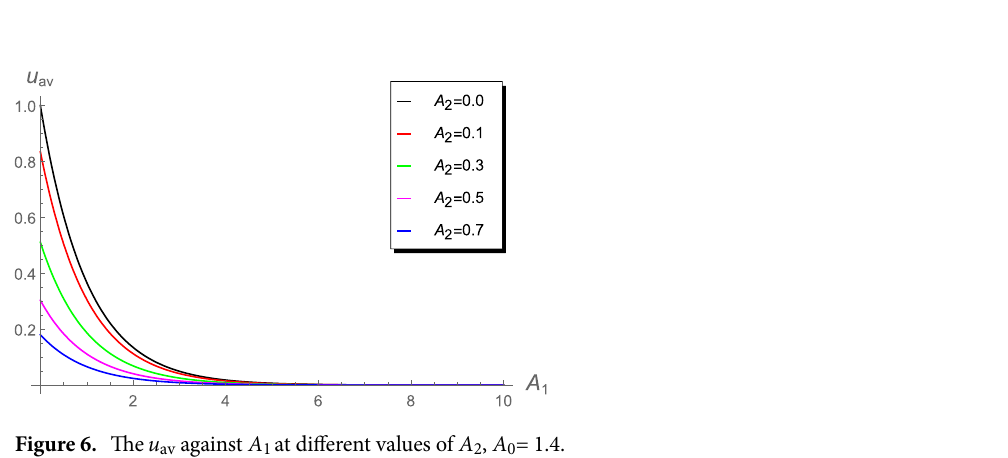
Table 3. Comparisons of present roots (cid:31) 1 , (cid:31) 2 , and (cid:31) 3 of Eq. (36) and the corresponding results in Ref. 4 using A Eqs. (48) ( 10 2 < 1000 ). ≤